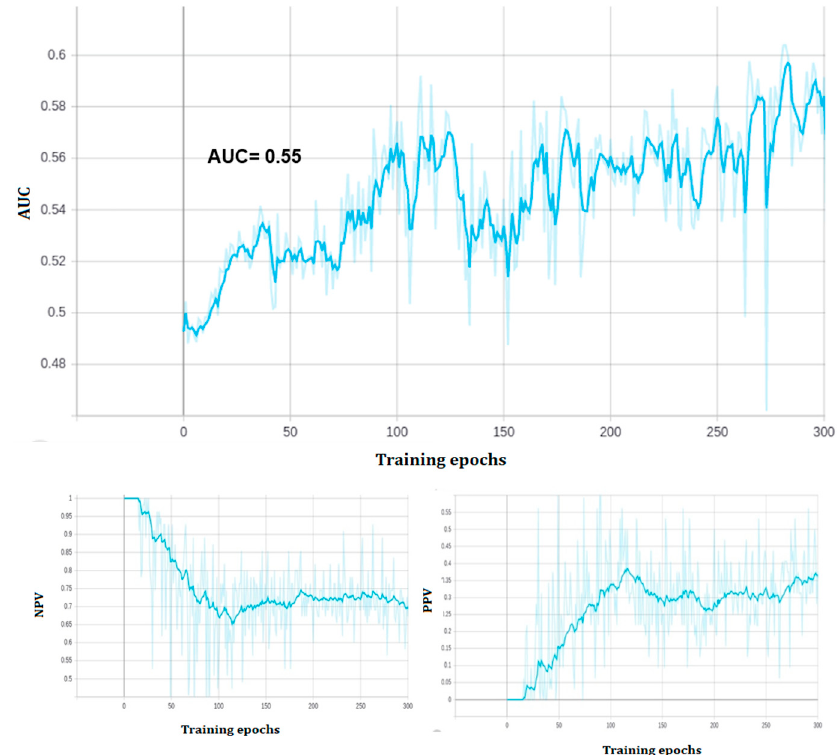
Figure 3. Phase1: Performance of the model during training (300 epochs). Top: validation AUC ROC. Low left: negative predictive value (NPV). Low right: positive predictive value (PPV).